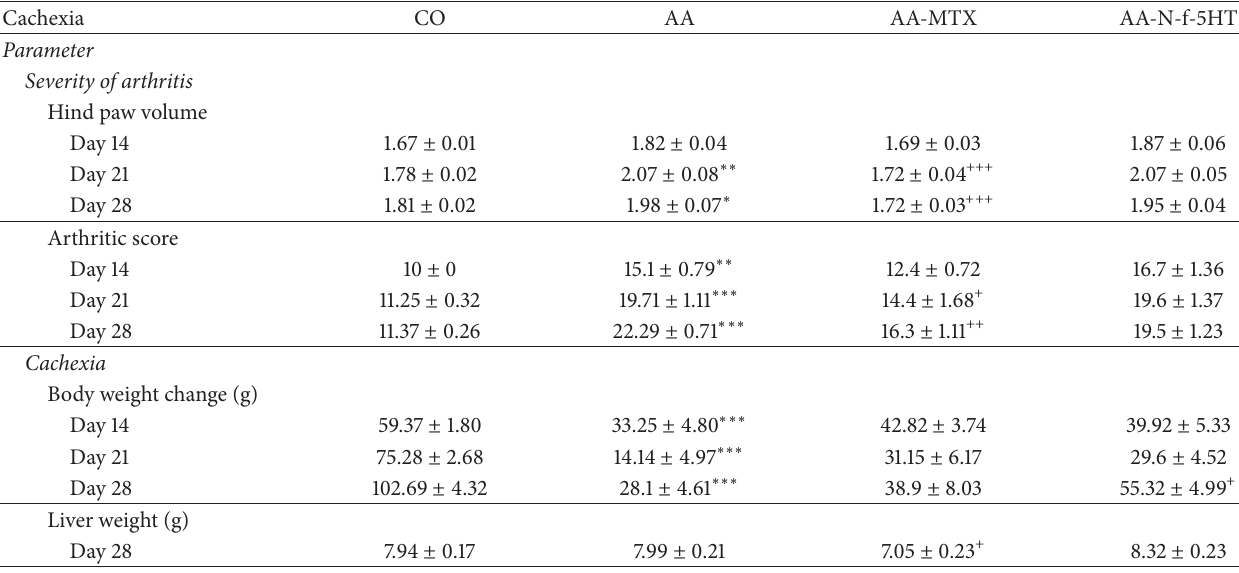
Table 3: Parameters of cachexia, liver weight, and severity of arthritis (hind paw volume and arthritic score) in rats with adjuvant-induced arthritis on experimental days 14 and 28 treated with N-f-5HT and